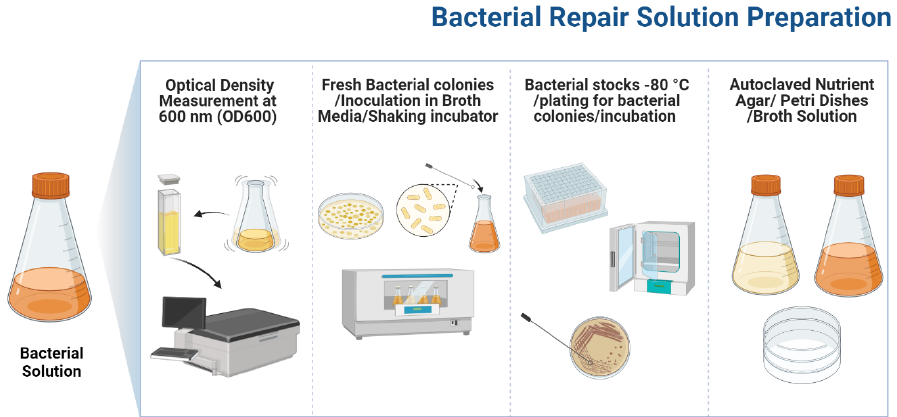
Figure 3. Biodeposition repair preparation .